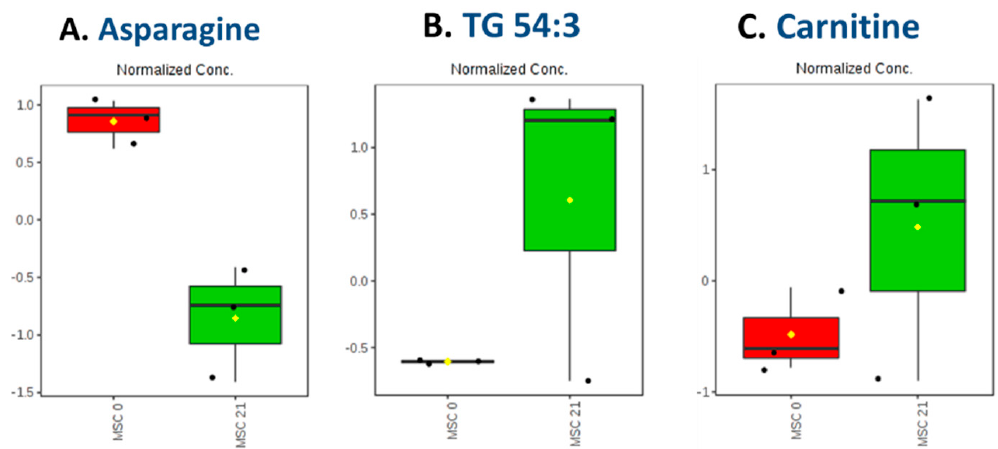
Figure A2. Compound-specific quantification of TG 54:6 using external calibration and internal standardization (n = 3) by 13 C-labeled TG 54:6 (LILY technology [15]).